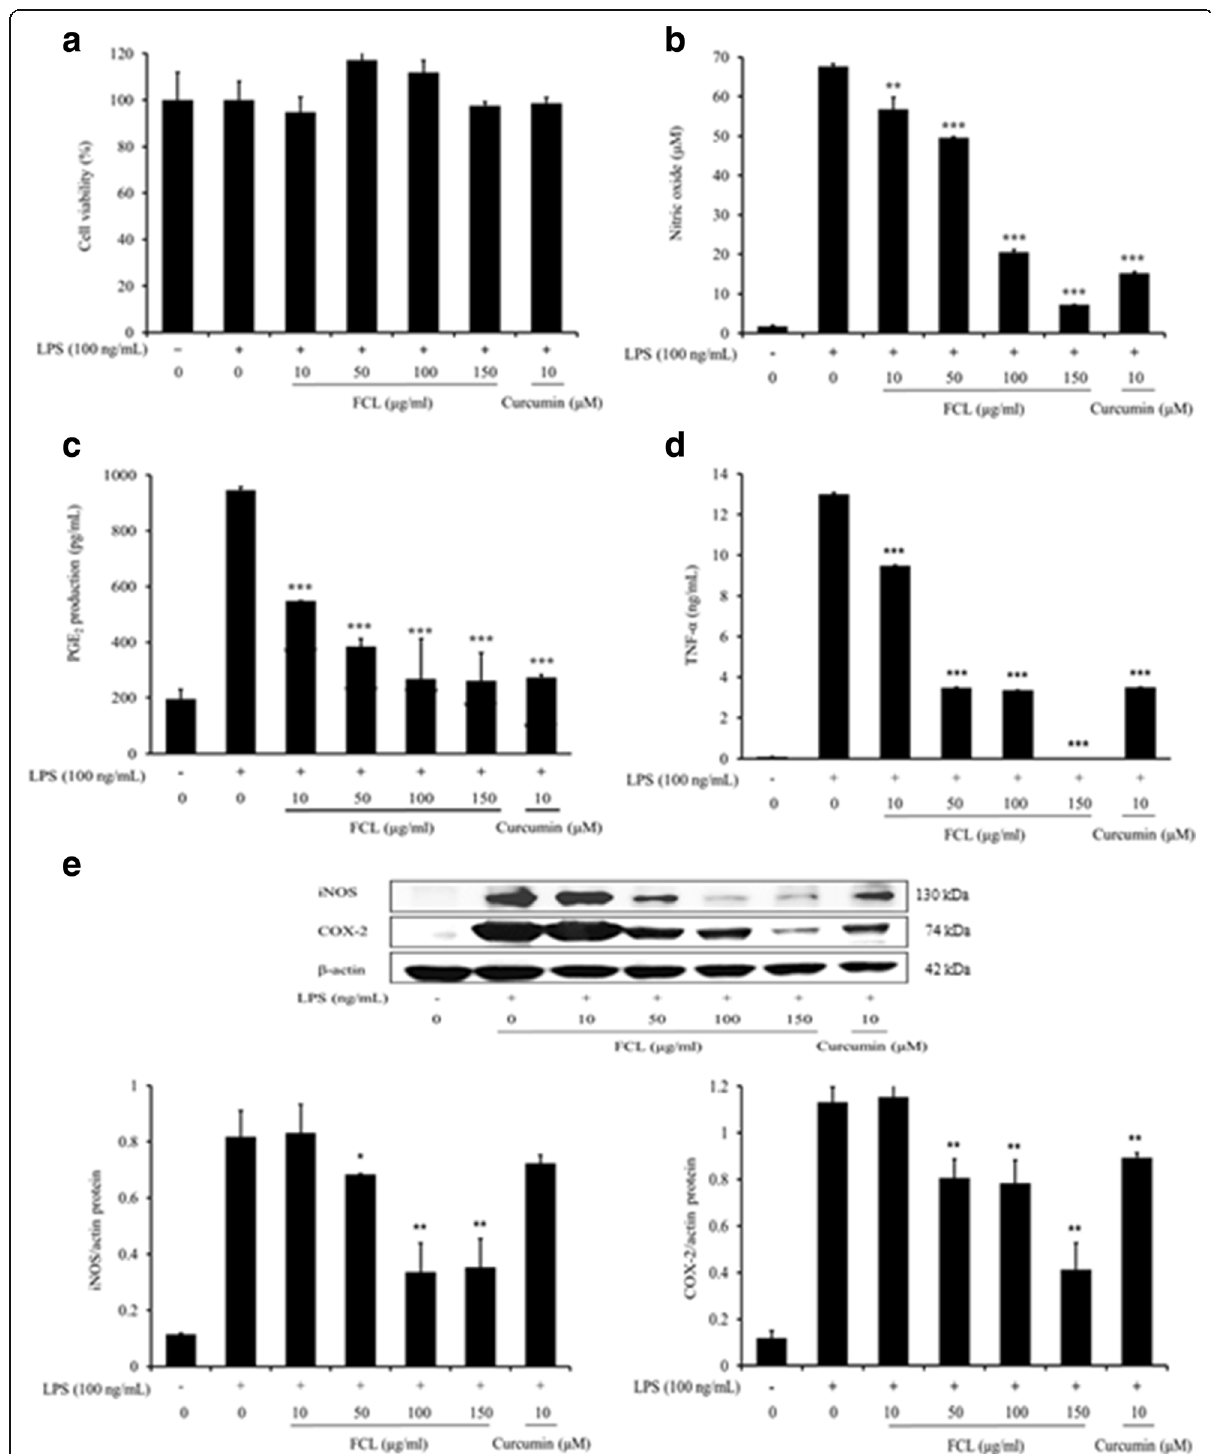
Fig. 2 Effects of FCL on cell viability and LPS-induced NO, PGE 2 , TNF- α production and iNOS, COX-2 expressions in BV2 cells. Cells were pretreated with various concentrations of FCL for 1 h and stimulated by LPS (100 ng/mL) for an additional 24 h. Cell viability ( a ) was measured by the MTT assay. NO production ( b ) was assayed in the stimulated cell culture media. Cytokine level was evaluated by enzyme-linked immunosorbent assay for PGE 2 ( c ), TNF- α ( d ). Total cell lysates (20 μ g) were examined for iNOS (130 kDa) and COX-2 (74 kDa) protein expressions by Western blotting, and the relative expression levels were normalized by an internal control, β -actin (42 kDa) ( e ). Data present means ± SD in triplicate. * P < 0.05, ** P < 0.01, *** P < 0.001 vs LPS